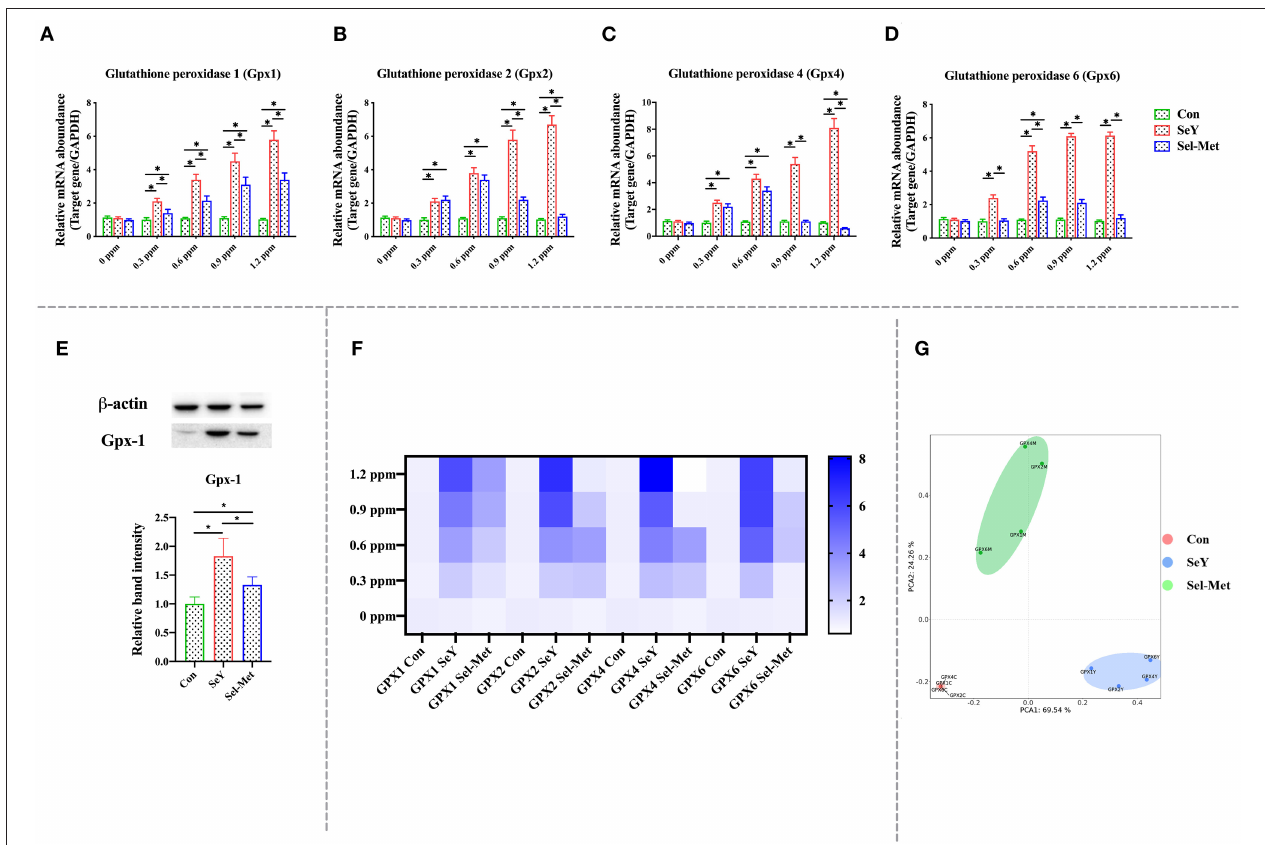
FIGURE 3 | Effects of SeY and Sel-Met addition on the mRNA expression of glutathione peroxidase family in PMECs. The cells were incubated with different concentrations of SeY and Sel-Met (0, 0.3, 0.6, 0.9, and 1.2 ppm) for 24h, respectively, and then collected for detection. Data were expressed as mean ± SEM ( n = 6), and * indicated statistically significant difference ( P < 0.05). (A–D) mRNA expression levels of GPXs family were detected by qPCR. (E) The relative protein levels of GPX1 were analyzed by Western blotting. (F) Heat map comparison of mRNA expression levels of GPXs. (G) PCA score plot results compared the mRNA expression of GPXs between the three